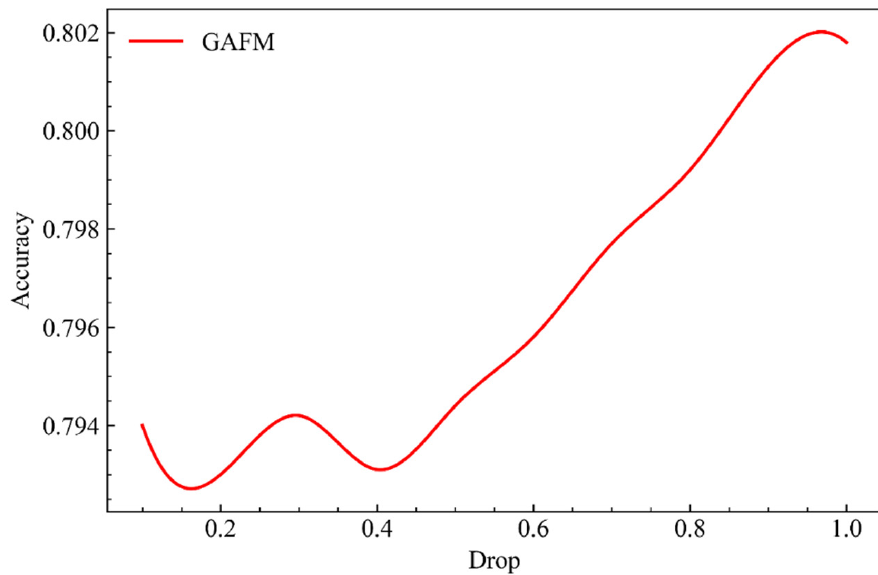
Figure 6. Prediction accuracy of GAFM under drop.